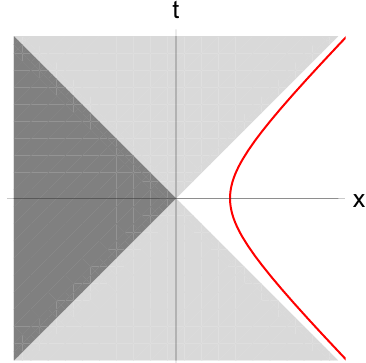
Figure 3. Hyperbolic trajectory of a accelerated qubit. In light gray are shown spacetime regions partially causally disconnected from the qubit. In dark gray is the region totally causally discon- nected from the qubit. The white region is the causally accesible region of the qubit, the border of this region represents an event horizon for the accelerated